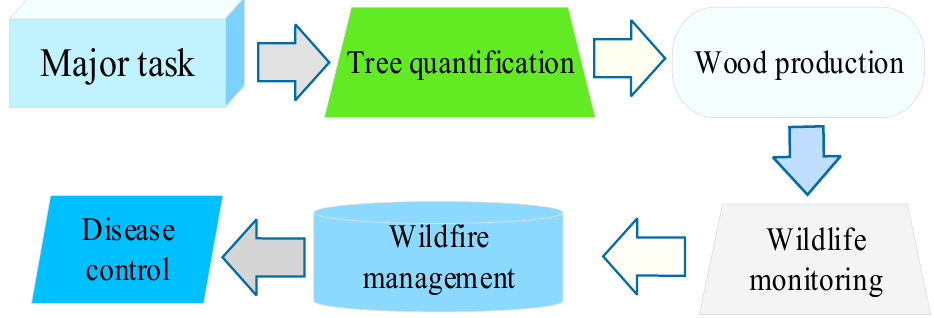
Figure 5. Major unmanned system-supported applications in forestry.